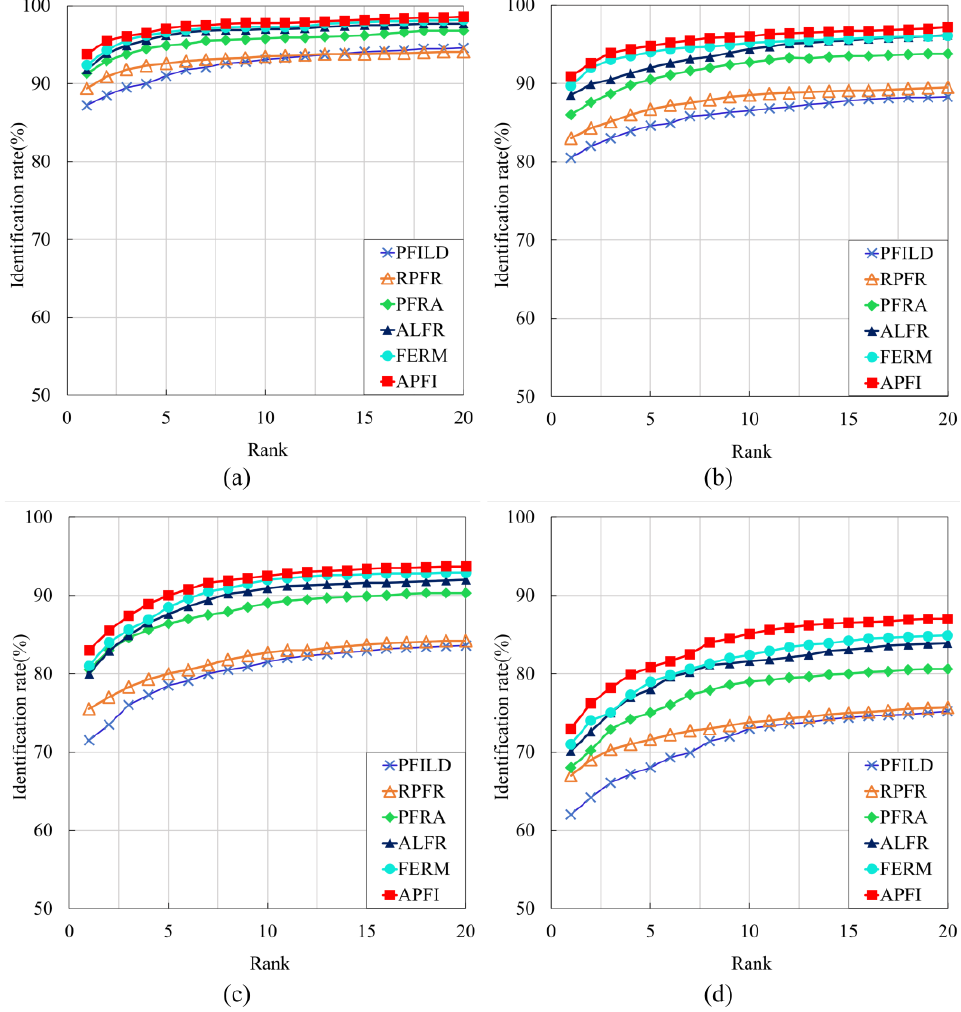
Figure 6. Identification accuracy of different algorithms on NIST-SD4 dataset. ( a ) shows the identification performance of different methods on fingerprint images with an effective area of 100%. ( b ) shows the identification performance of different methods on fingerprint images with an effective area of 75%. ( c ) shows the identification performance of different methods on fingerprint images with an effective area of 50%. ( d ) shows the identification performance of different methods on fingerprint images with an effective area of 25%.